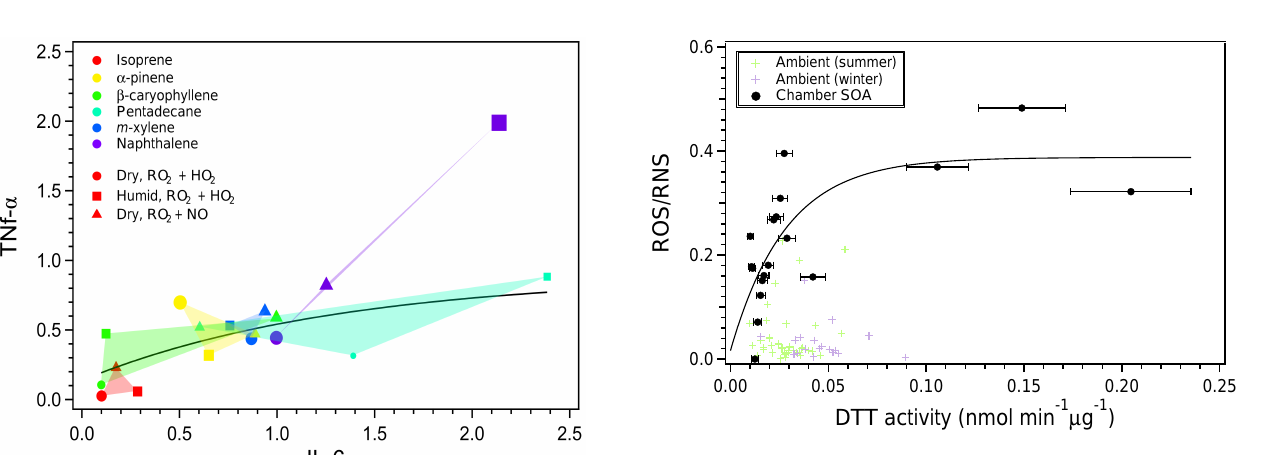
Figure 5. ROS/RNS production and intrinsic DTT activities for chamber SOA and ambient samples collected around the greater Atlanta area. All samples were analyzed using the method outlined in Cho et al. (2005) and Tuet et al. (2016). Ambient samples are col- ored by season as determined by solstice and equinox dates between June 2012 and October 2013 (Tuet et al., 2016). A fitted curve for laboratory-generated samples is shown as a